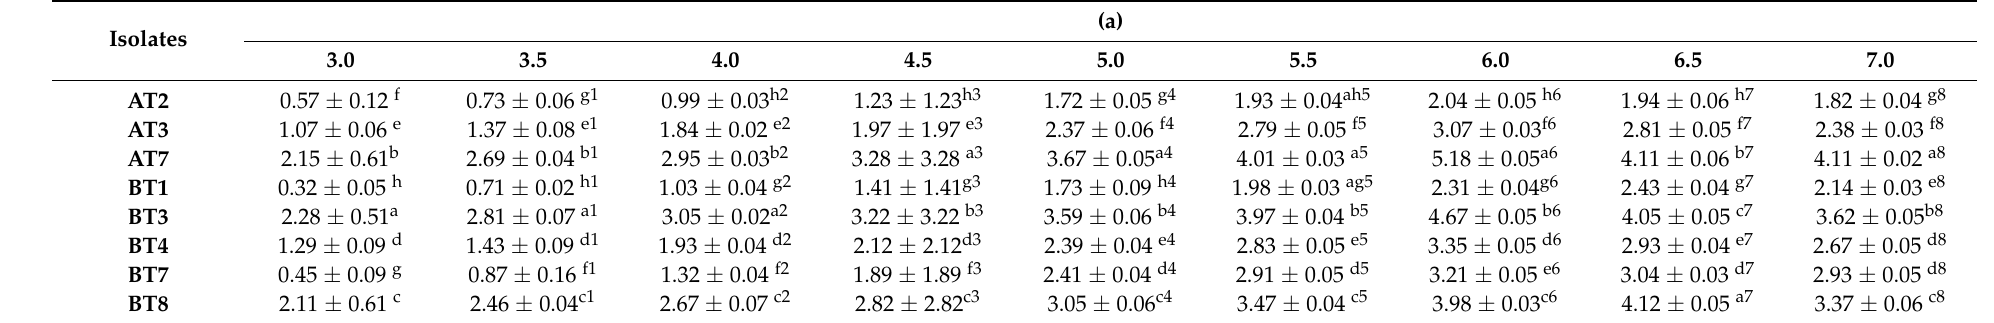
Table 3. Effect of pH on chitinase activity of various Trichoderma isolates.